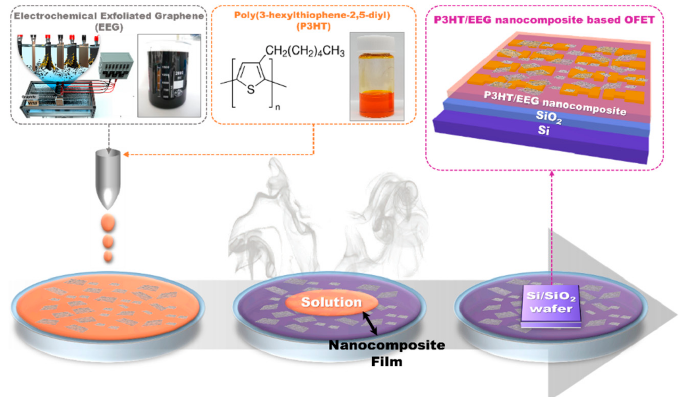
Figure 1. Schematic illustration of fabrication process of poly(3-hexylthiophene) (P3HT) / electrochemically exfoliated graphene (EEG) nanocomposite film and organic field-e ff ect transistor (OFET) device via solution floating